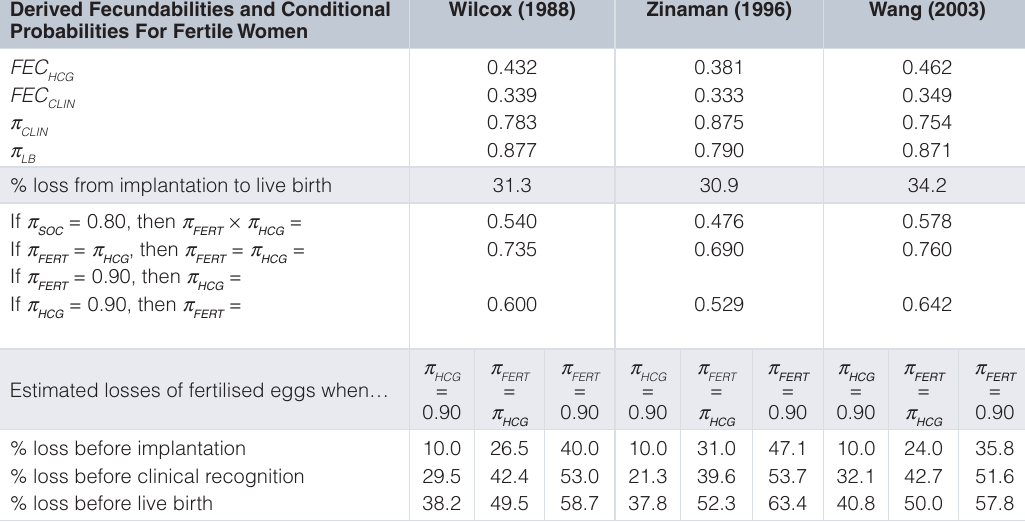
Table 3. Estimates of conditional probabilities for different stages of the reproductive process for reproductively normal subjects. Estimates of hCG ( FEC derived from three hCG pregnancy studies as described in the text. π Wilcox 6 , Zinaman 7 and Wang 8 study reports. Estimates of fertilised egg loss up to implantation, clinical recognition and birth are provided, based on three scenarios: (i) high implantation probability ( π implantation and fertilisation probabilities ( π of sperm-ovum-co-localisation ( π